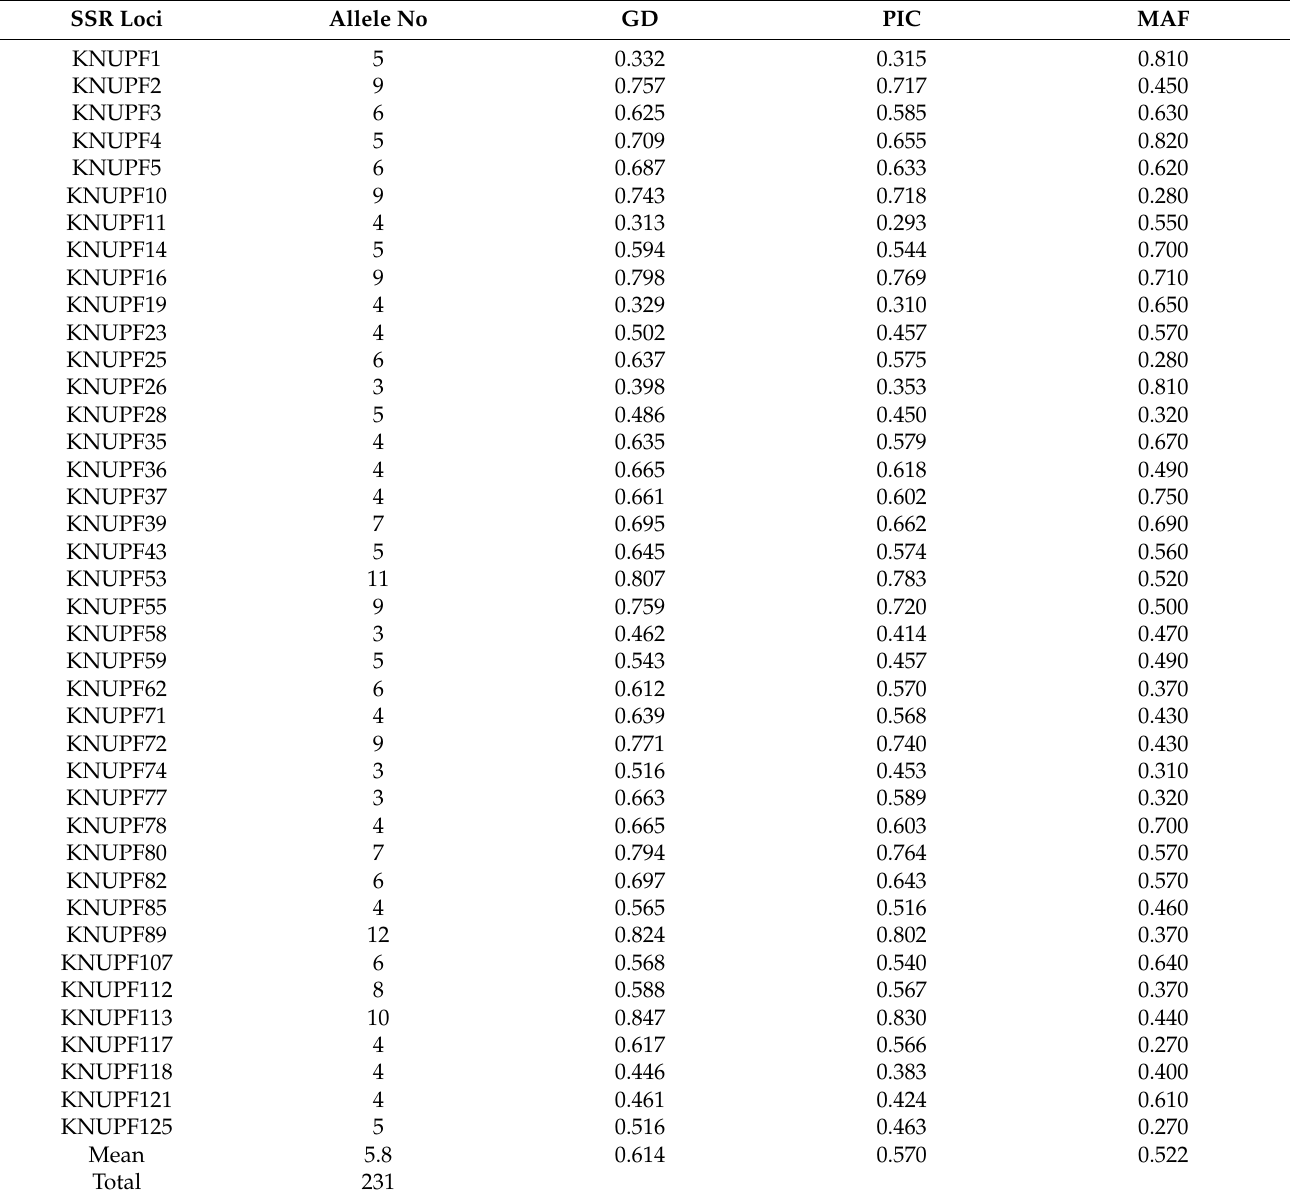
Table 3. Estimates of the allele number, GD, PIC, and MAF of 40 SSR primer sets among 100 Perilla accessions. SSR Loci